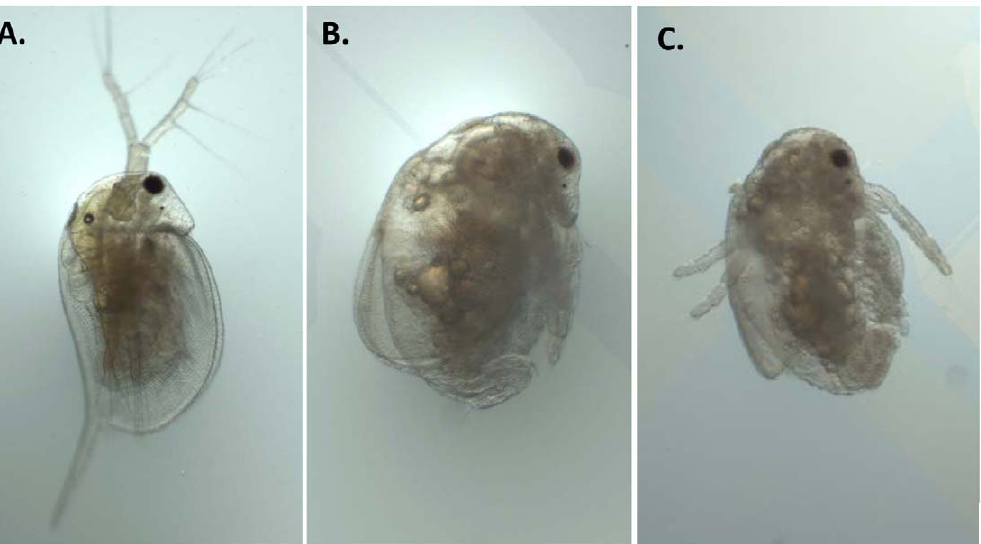
Figure 6. Developmental abnormalities among neonatal daphnids resulting from maternal exposure to NaNO 2 . Images presented are ( A ) normal control neonate, ( B ) and ( C ) neonates derived from maternal exposure to 1.0 and 2.0 mg N/L NaNO 2 , respectively.